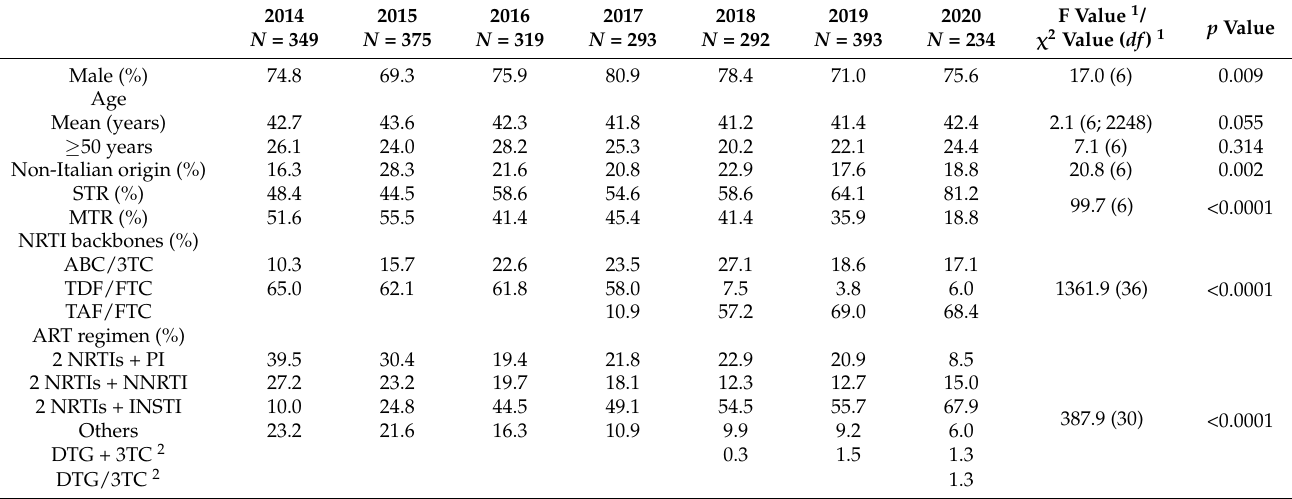
Table 1. Characteristics for treatment-naïve patients